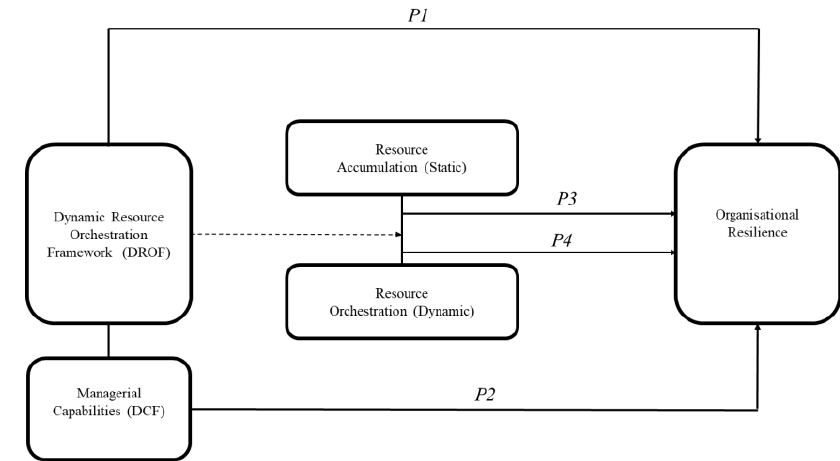
Figure 2: The dynamic resource orchestration